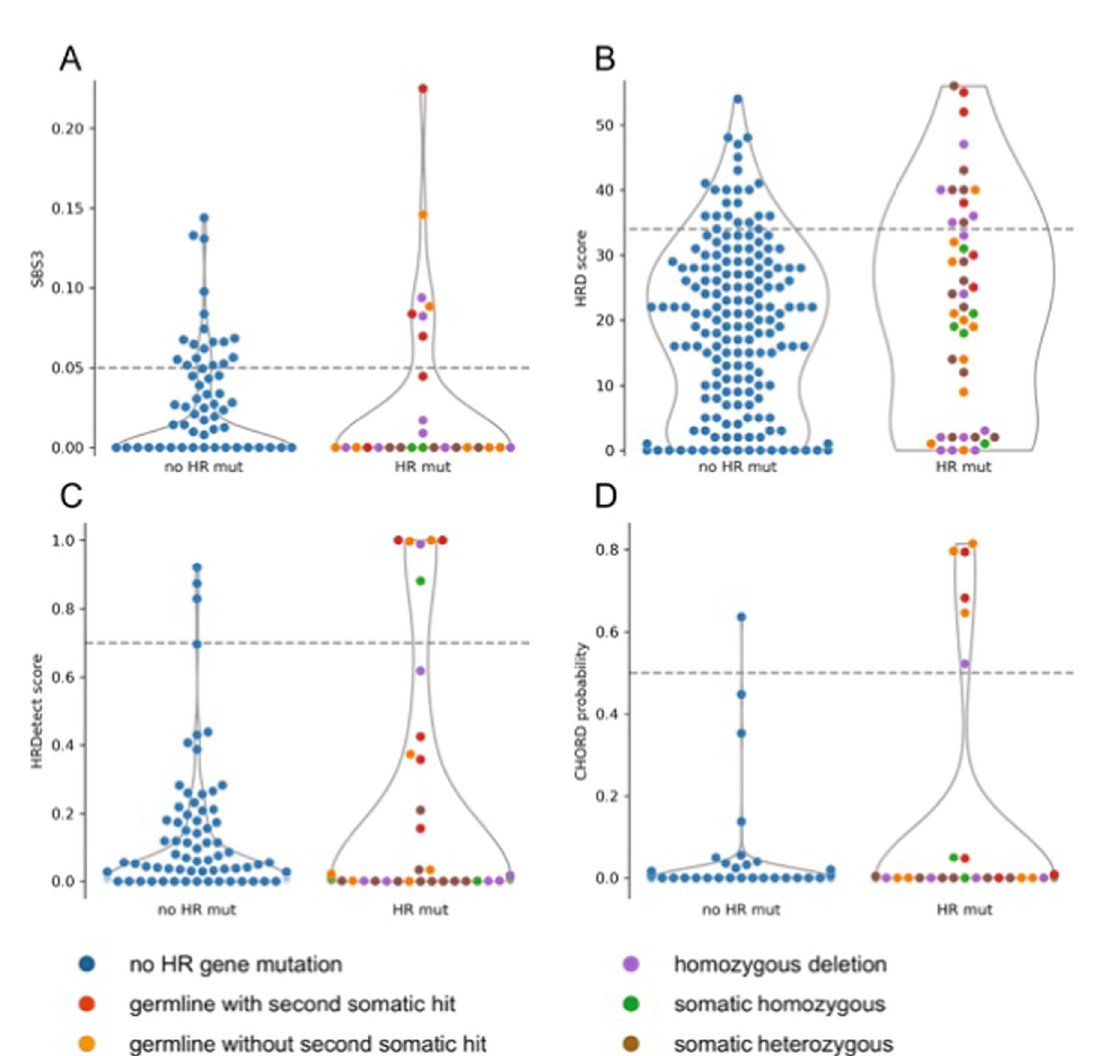
Fig. 2 Violin plot of HRD metrics (SBS3, HRD score, HRDetect and CHORD) with pathogenic HR gene alterations. SBS3 ( A ), HRD score ( B ), HRDetect score ( C ) and CHORD probability ( D ) depicted in the combined gastrointestinal and thoracic cohorts with or without pathogenic or deleterious mutations or homozygous deletions in the 51 HR genes listed in the “ Methods ” . Deleterious mutations included nonsense and frameshift mutations. Thresholds as indicated by the dashed lines are 0.05 (SBS3), 34 (HRD score), 0.7 (HRDetect score) and 0.5 (CHORD